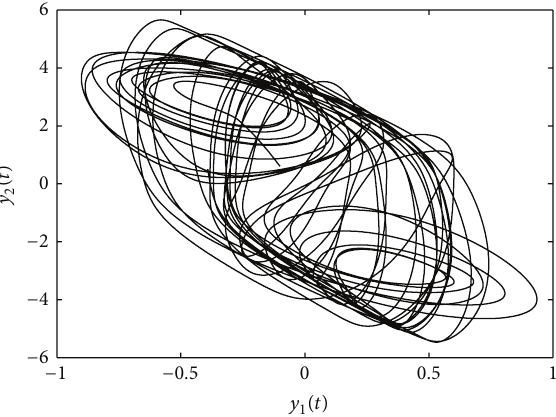
Figure 2: Chaotic behavior of the slave system with 𝑢(𝑡) = 0